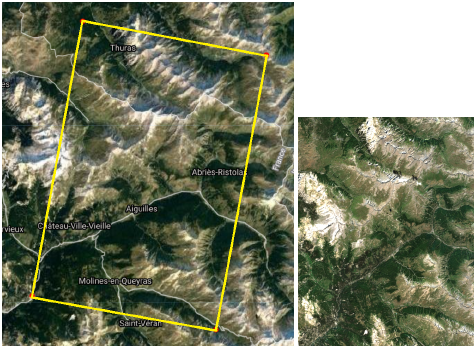
Figure 5. Selected area and Reactiv color composition applied to the observation period